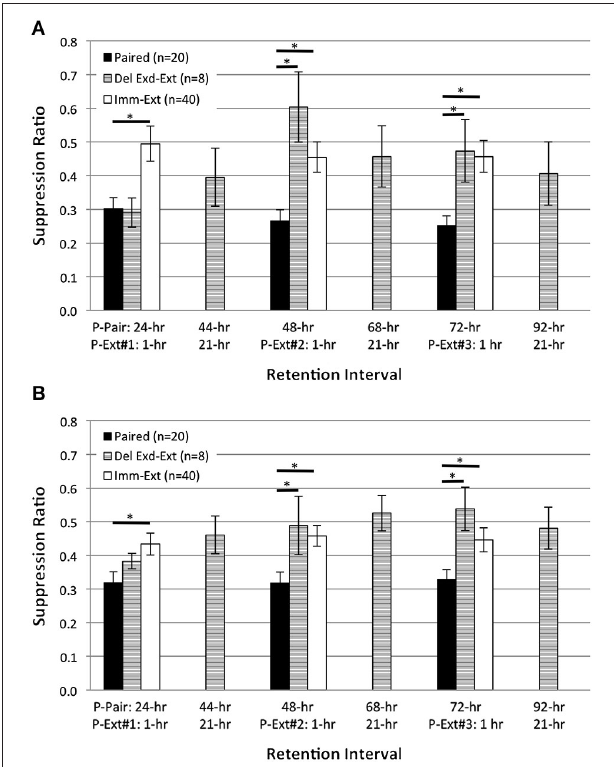
FIGURE 6 | Extended delayed extinction training attenuates pairing-produced phototactic suppression . Summary data for start (A) and finish (B) latency suppression ratio (SR) scores measured at six different RIs following the end of acquisition training. X-axis labels show the RI time post paired training (P-Pair) or post extinction training (P-Ext) for three different extended extinction sessions (50 light-alone